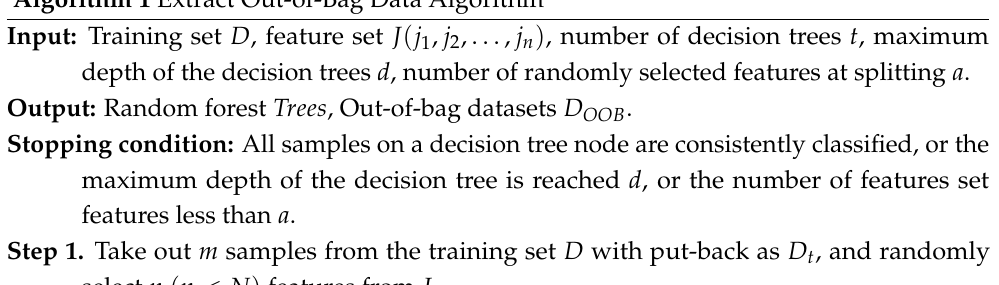
Algorithm 1 Extract Out-of-Bag Data Algorithm